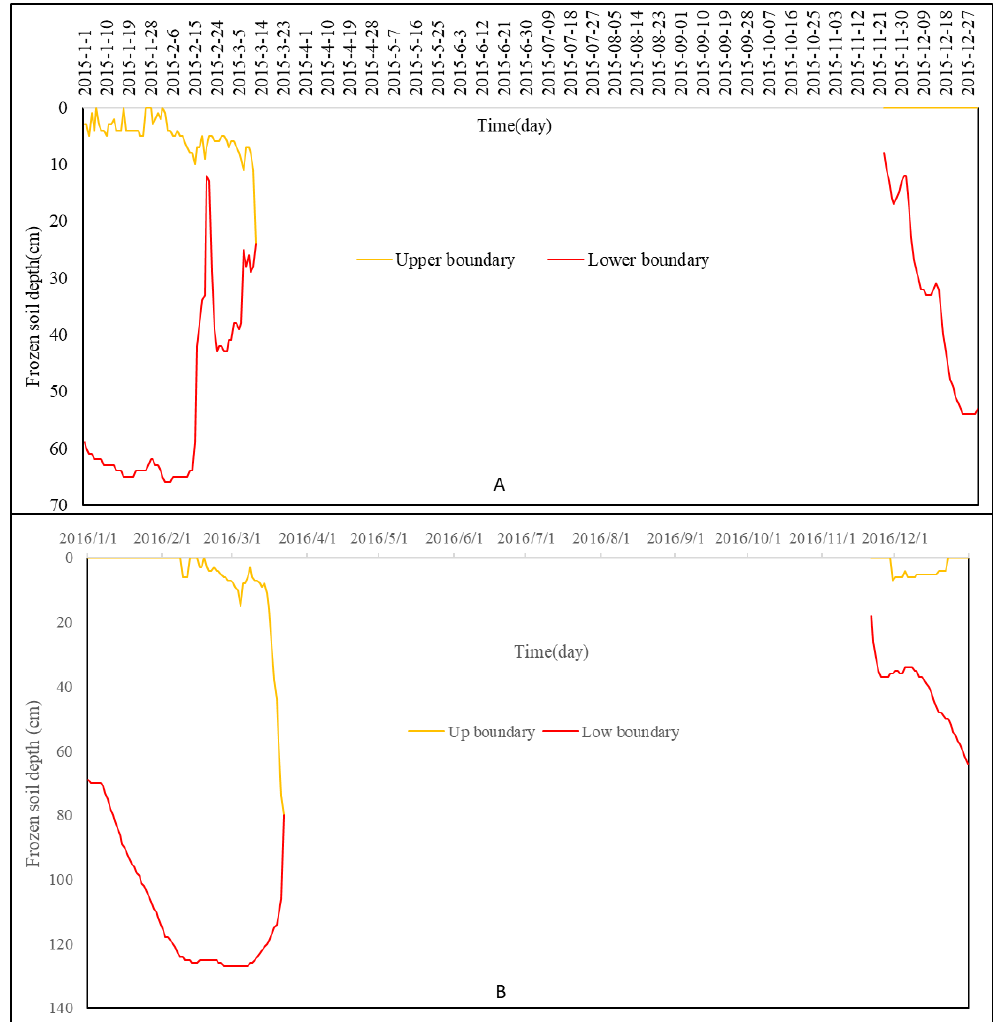
Figure 11. Frozen soil boundary of the field in 2015. ( A ) frozen soil boundary changes in 2015; ( B ) frozen soil boundary changes in 2016.